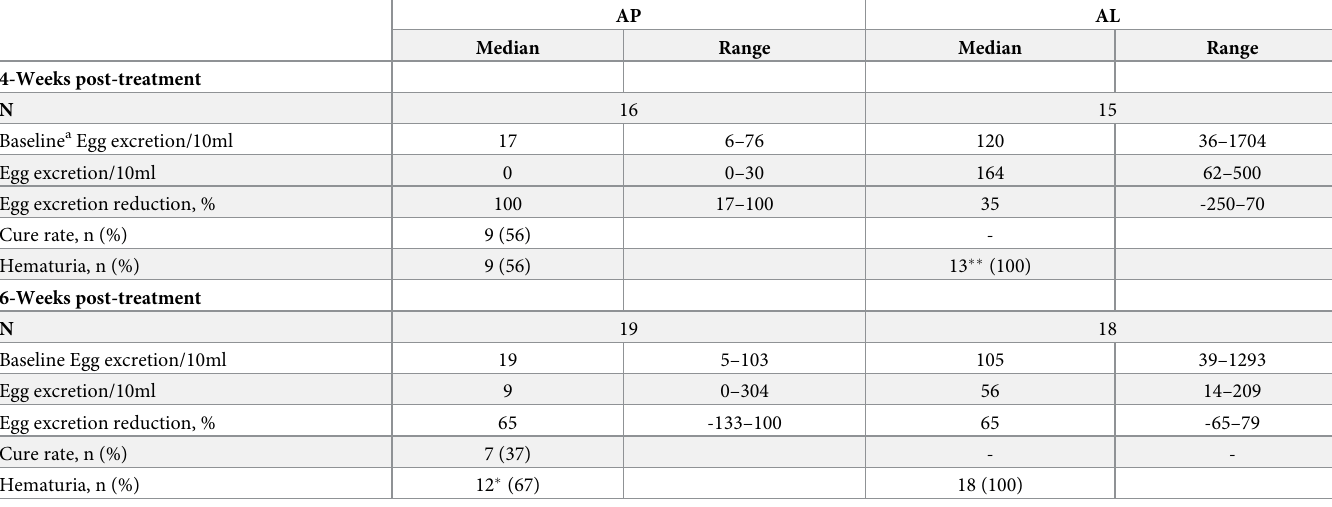
Table 2. Schistosoma egg excretion reduction and cure rate post malaria